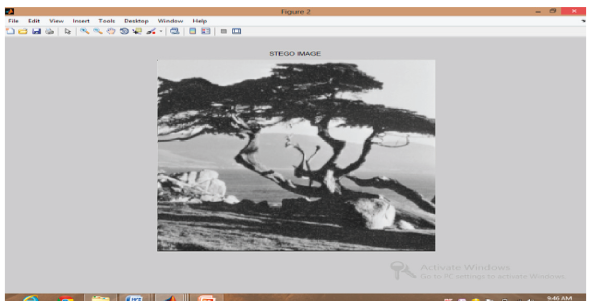
Figure 8: Stego image of trees.